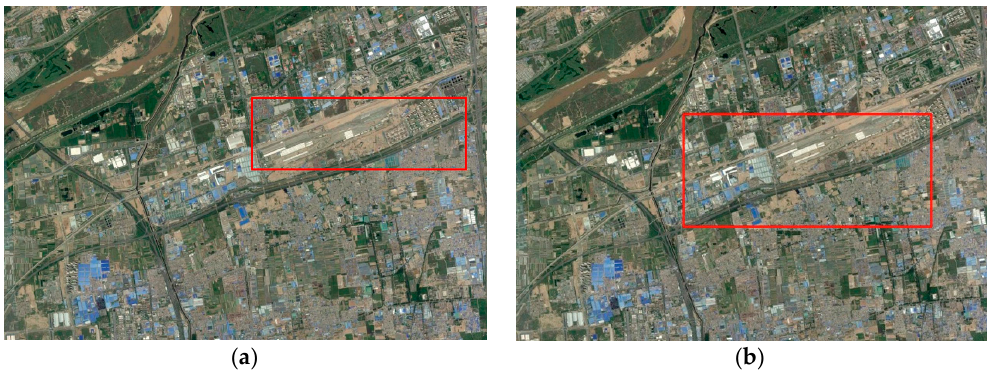
Figure 10. False detection result in an image with no airport in it. ( a ) Faster R-CNN; ( b ) LSD + AlexNet. [Image courtesy of Google Earth].